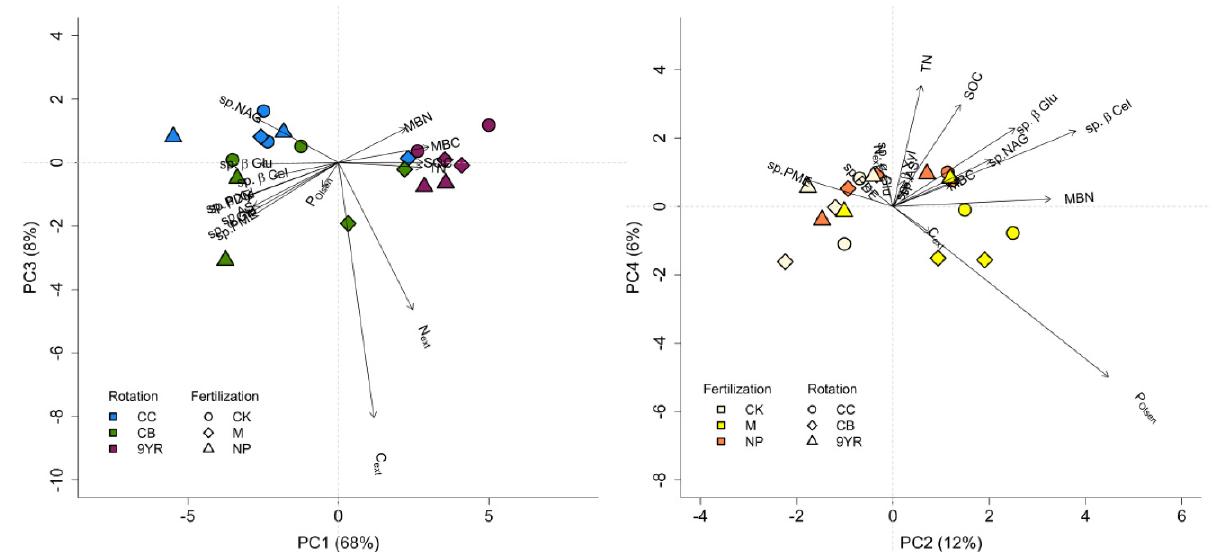
Figure 4. Principal component analysis plot including the soil C and N pools, the bioavailable phosphorous (P), and the specific soil enzymatic activities: extractable C and N (C ext , N ext ), microbial biomass C and N (MBC, MBN), total N (TN), soil organic C (SOC), available P (P Olsen ), β -glucosidase (sp. β -Glu), α -glucosidase (sp. α -Glu), β -xylosidase (sp. β -Xyl), β -cellobiosidase (sp. β -Cel), N-acetyl- β -glucosaminidase (sp.NAG), phosphomonoesterase (sp.PME), and phosphodiesterase (sp.PDE) activities. Left panel: principal components 1 and 3, where rotation is dominant discriminating factor; right panel: principal components 2 and 4, where fertilization is dominant discriminating factor. See Table 4 for PCA and ANOVA results.